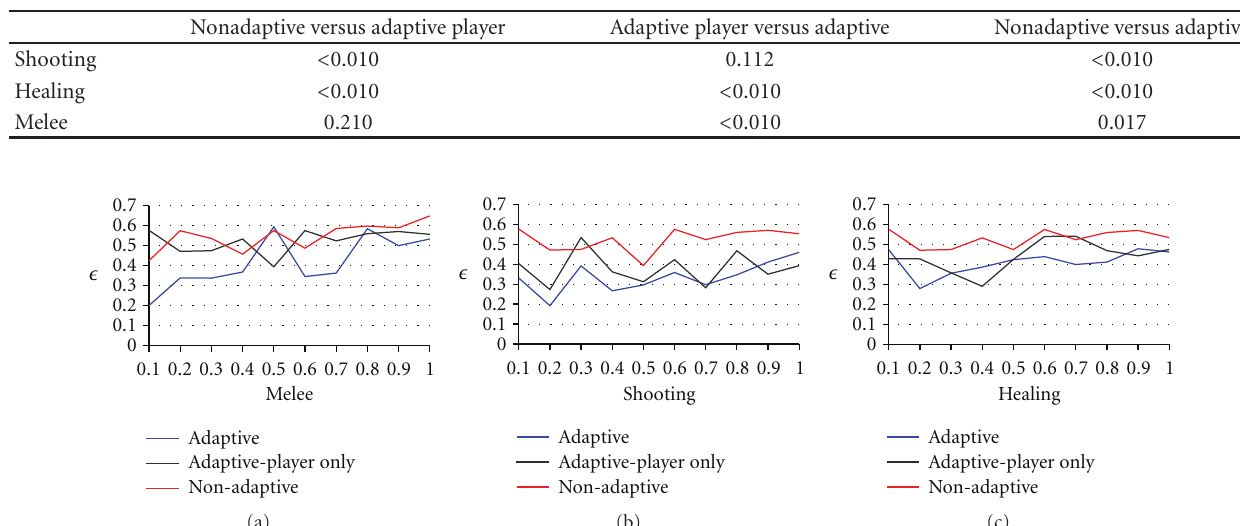
Table 2: Versatility test results for the fundamental TAP experiments: Table of t -test P -values.